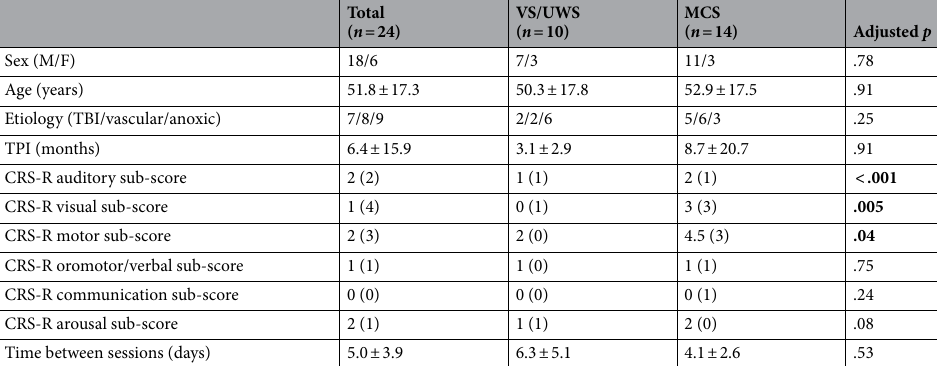
Table 2. Patients’ characteristics as a function of clinical diagnosis. Descriptive data are reported as mean ± standard deviation for continuous variables, as median (inter-quartile range) for ordinal variables and as counts for categorical variables. Patients’ best CRS-R index and sub-scores out of the repeated examination is reported. Univariate statistics are based upon the Mann–Whitney U test or χ 2 test, as appropriate. p values was adjusted with the false discovery rate correction. Significant differences are reported in bold. Abbreviations: VS/UWS = Vegetative State/Unresponsive Wakefulness Syndrome; MCS = Minimally Conscious State; M = Male; F = Female; TBI = Traumatic Brain Injury; TPI = Time Post-Injury; CRS-R = Coma Recovery